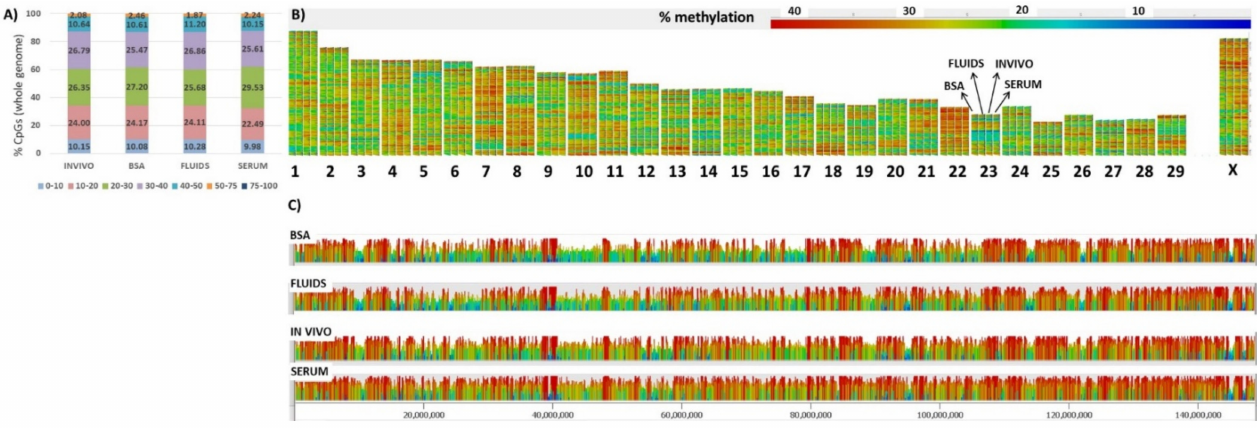
Figure 1. ( A ) Distribution of methylation percentages across tiles of 100 CpGs on the bovine blastocyst by group. ( B ) Do- mainogram shows quantitation of the blastocyst methylation over the whole genome for each group (BSA, FLUIDS, INVIVO, SERUM) at every chromosome (1–29, X). ( C ) Browser shot of methylation landscape of the four groups analyzed (whole